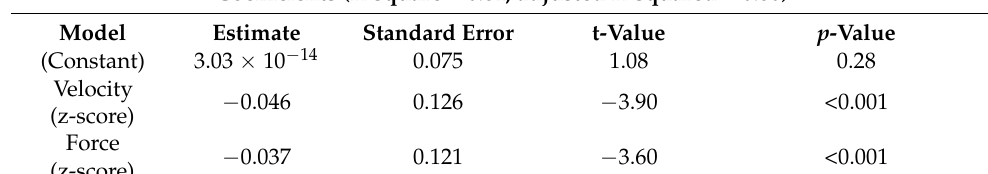
Table 2. Multiple linear regression analysis to predict swimming performances based on z-scored velocity and force generated in the single pull-up test. The analysis considers both the distance and stroke groups.